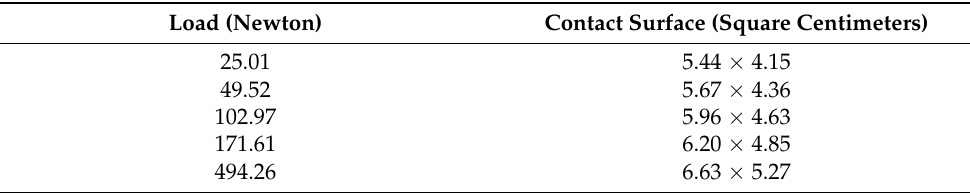
Table 2. Surface extension of the sensor pad due to external